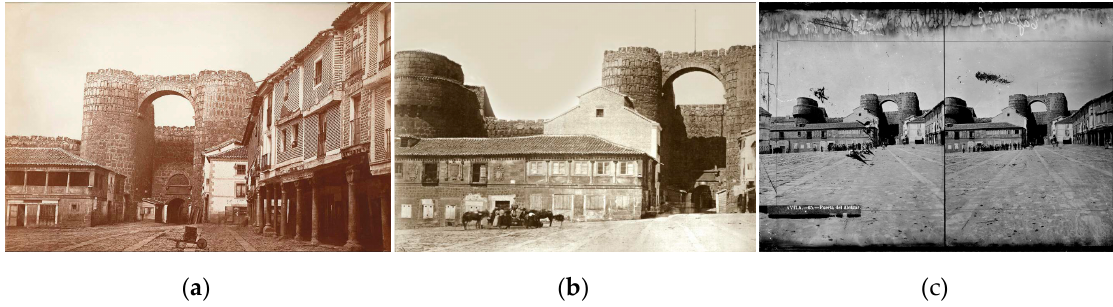
Figure 3. Old images of extramural buildings. (a) Mariano Moreno, from Moreno archive (00004_C);